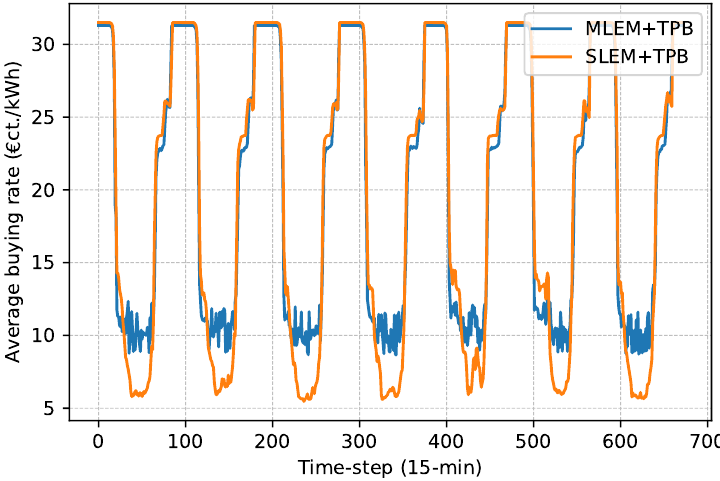
Figure 9. Community average trade price with the TPB clearing mechanism for one